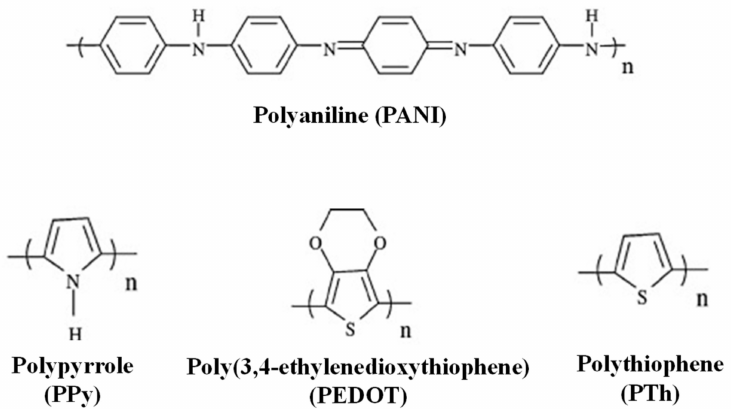
Figure 15. Molecular structures of the most used conducting polymers combined with the semiconducting metal